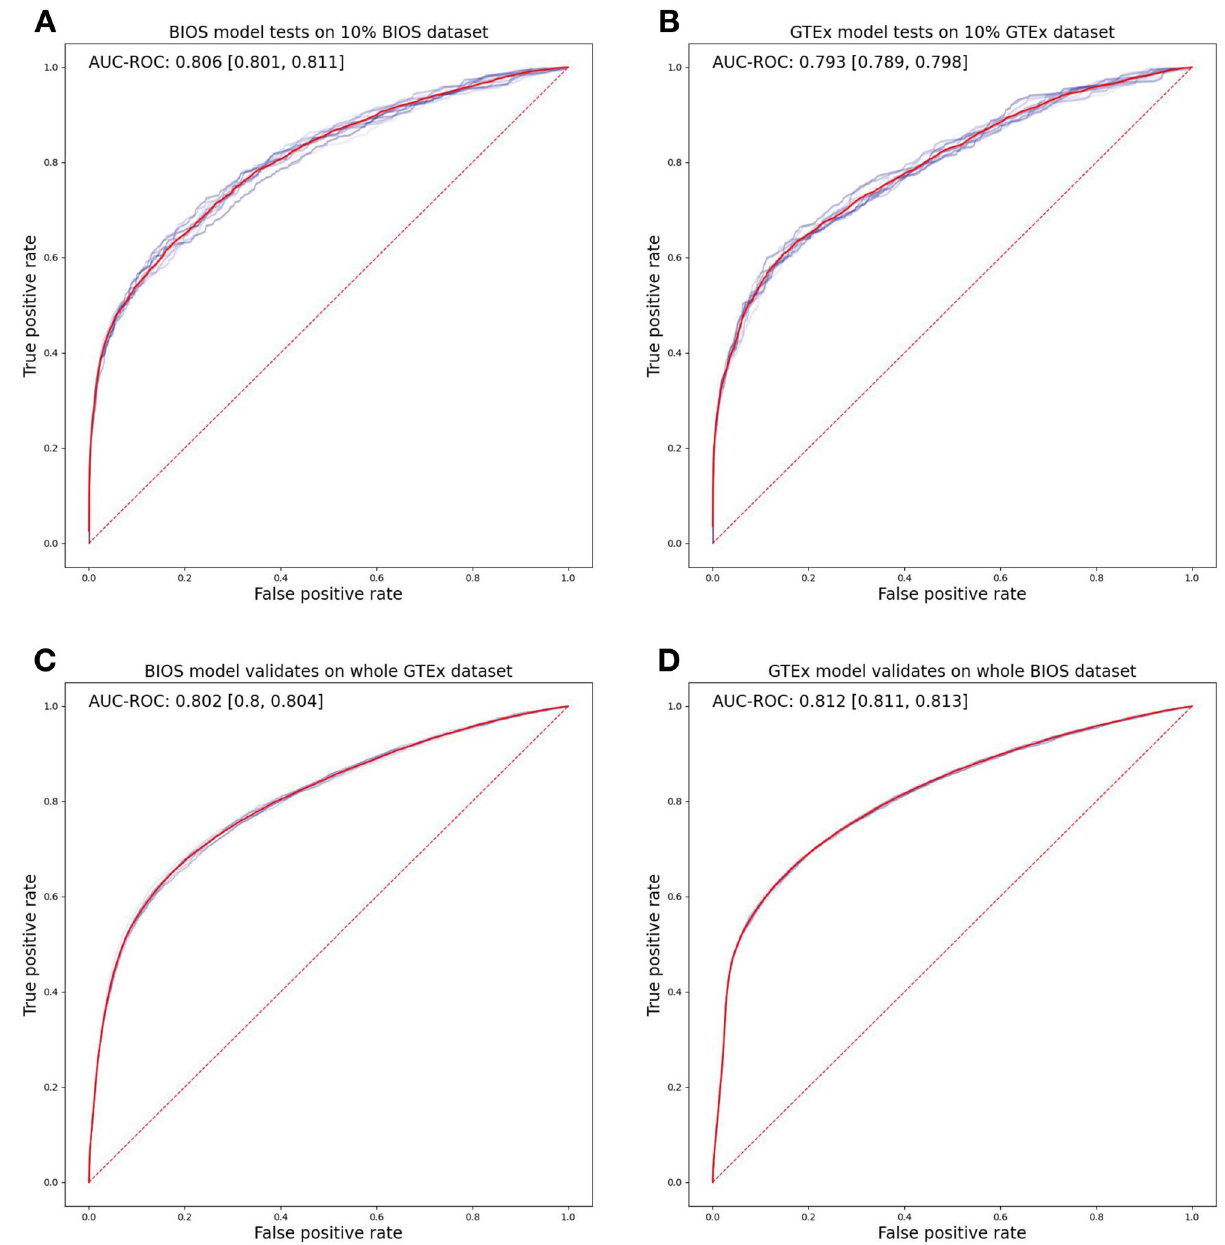
Figure 2. ROC curves of ASE prediction models. ROC curves to measure the performance of ASE prediction models on test sets with tenfold application for standard deviation. ( A ) shows the BIOS-trained model applied to 10% ‘leave out’ BIOS test sets. ( B ) shows the GTEx-trained model applied to 10% ‘leave out’ GTEx test sets. ( C ) shows the BIOS-trained model applied to the full GTEx set. ( D ) shows the GTEx-trained model applied to the full BIOS set. Plot was produced by Matplotlib 68 version 3.0.0 under Python 69 version